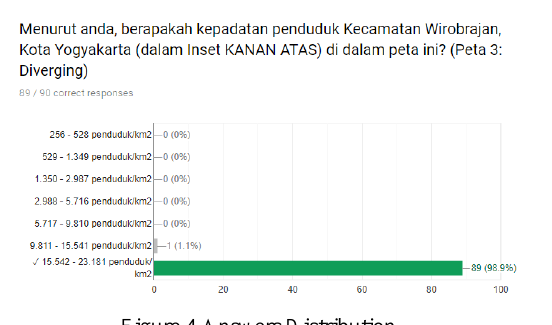
Figure 4 Answers Distribution